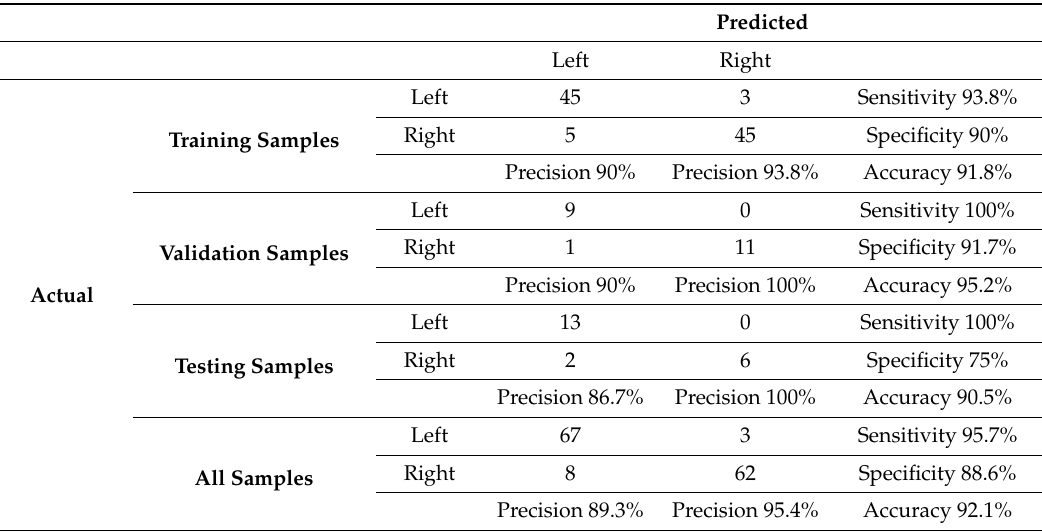
Table 3. Confusion matrices of artificial neural networks (ANN) classifier without GA-based feature selection. GA: genetic algorithm.